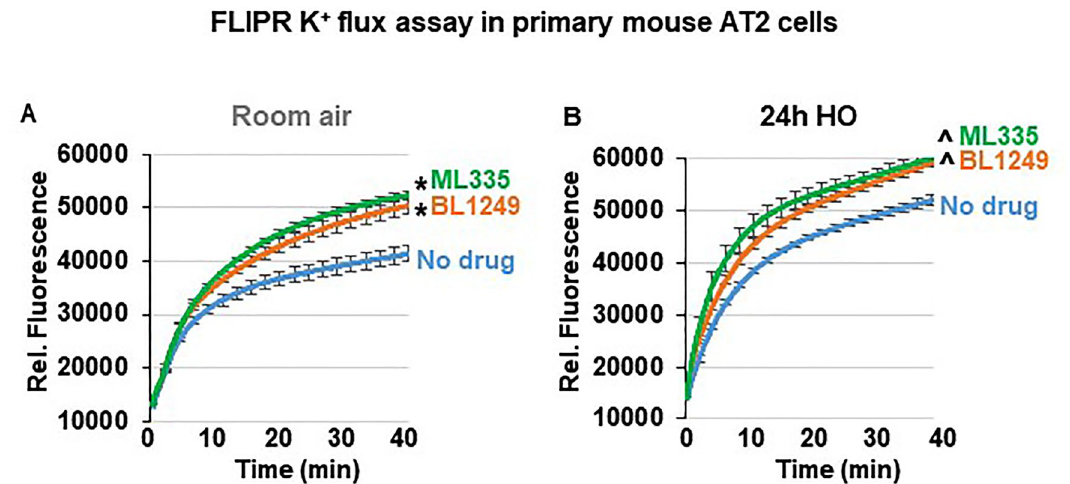
Figure 5. ML335 and BL1249 activate TREK-1 currents in primary mouse AT2 cells: Summary of n = 4–5 independent FLIPR curves (means ± SEM) showing that the TREK-1 activating compounds ML335 or BL1249 induce TREK-1 specific K + currents under both room air and HO conditions ( A , B ). In both room air and HO-treated cells, baseline background K + currents were observed (No drug). *compared to vehicle control (No drug) at room air, ^compared to vehicle control (No drug) after HO exposure; p ≤ 0.05, n = 4–5, individual experiments were run in